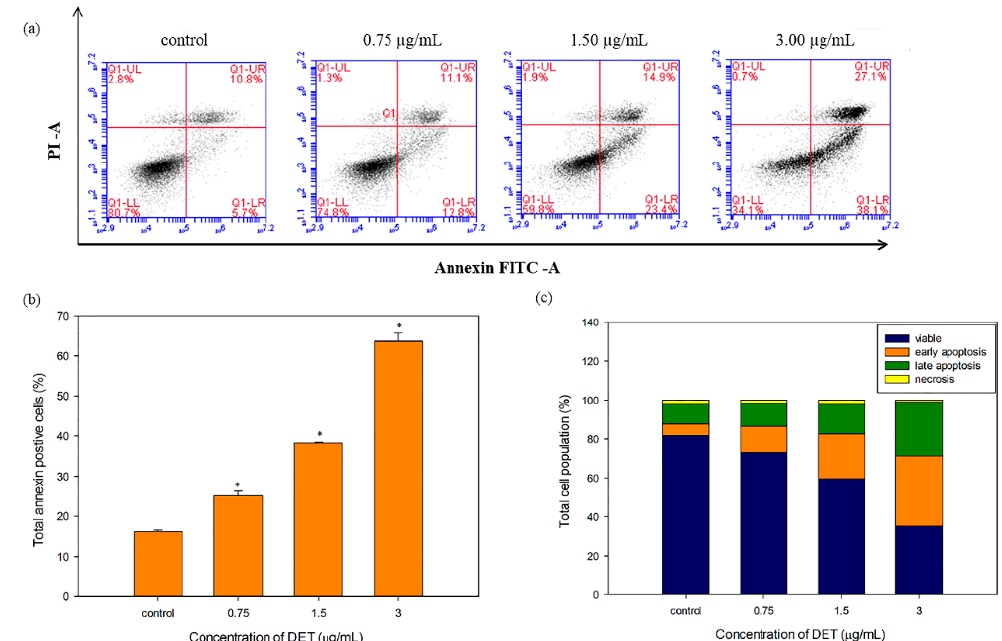
Figure 4. Externalization of phosphatidylserine induced by different concentrations of deoxyelephantopin (0.75–3.0 µg/mL) detected using Annexin V-FITC/PI staining at 24 h. ( a ) displayed the flow